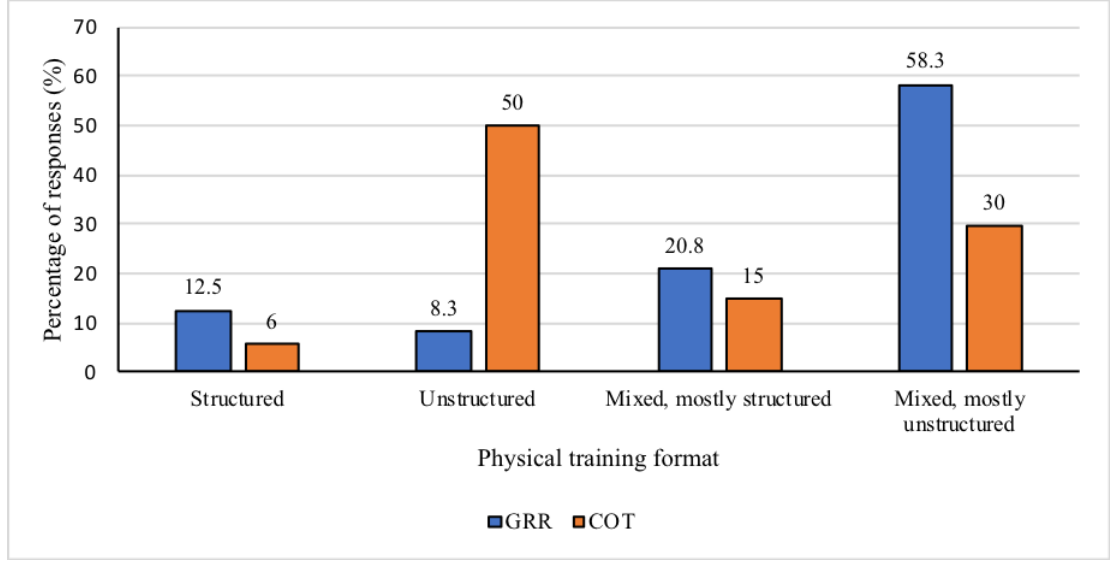
Figure 1. Percentage of responses on the physical training format for both special operations units, chosen from structured, unstructured, mixed (but mostly structured), or mixed (but mostly unstructured). COT = Tactical Operations Command; GRR = Rapid Response Group.